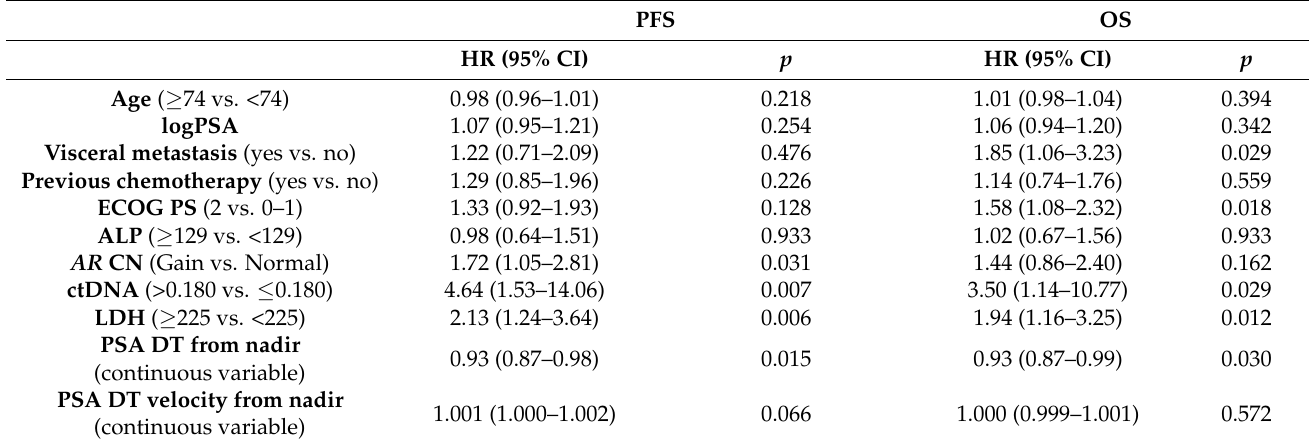
Table 4. Multivariate analysis of PSA progression-free